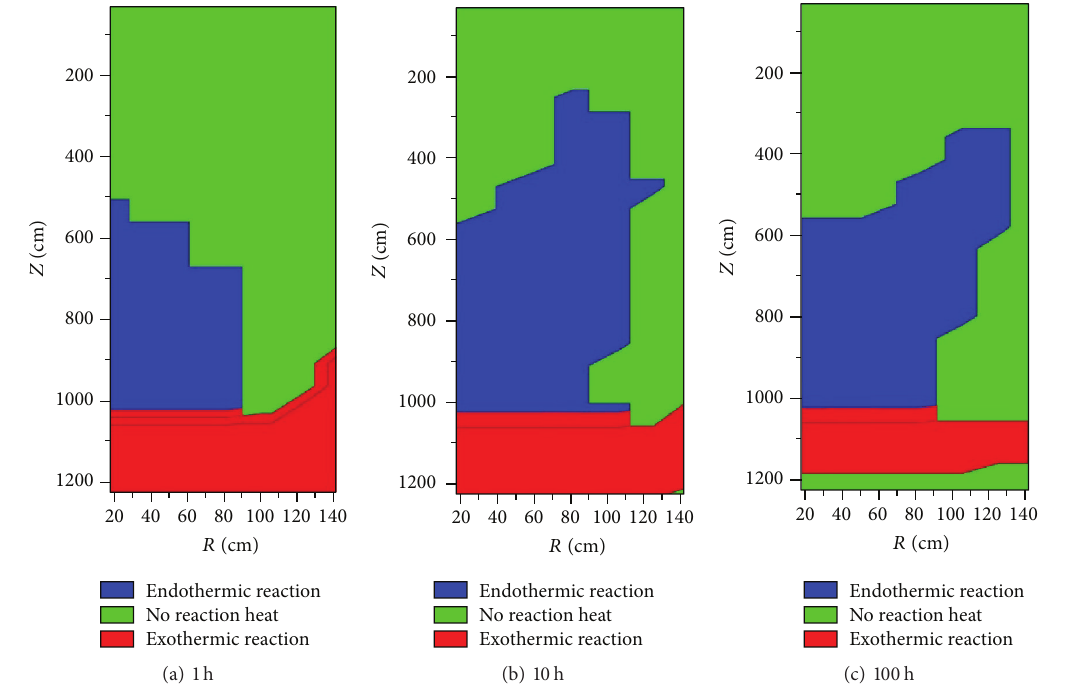
Figure 5: Schematic diagram of the chemical reaction heat distribution in the reactor core and the bottom reflectors: (a) 1h, (b) 10 h, and (c) 100h.